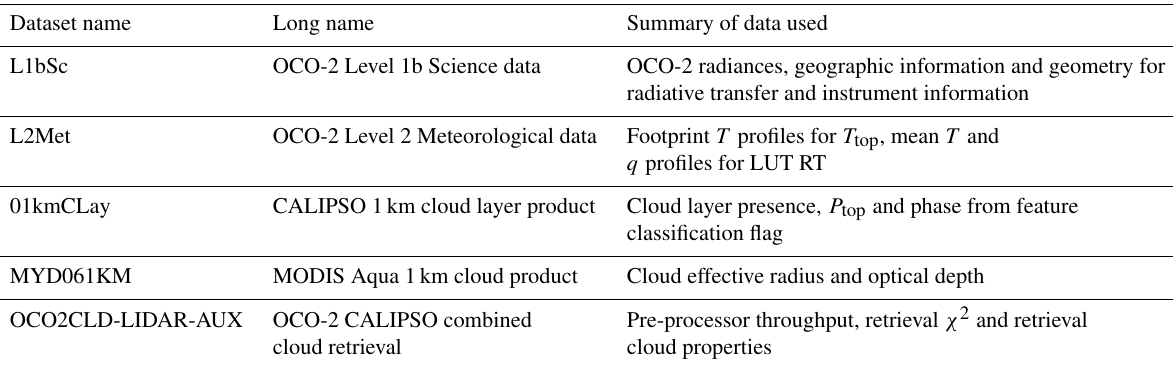
Table 2. Summary of datasets used. Note that we use the 01kmCLay and MYD061KM products collocated with OCO-2 as described in Taylor et al.